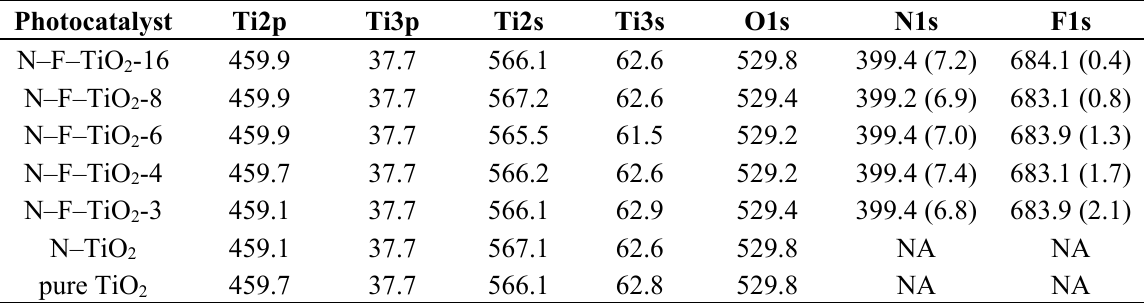
Table 1. Binding energy (eV) and amounts (%) of N and F for N–F–TiO 2 -3, N–F–TiO 2